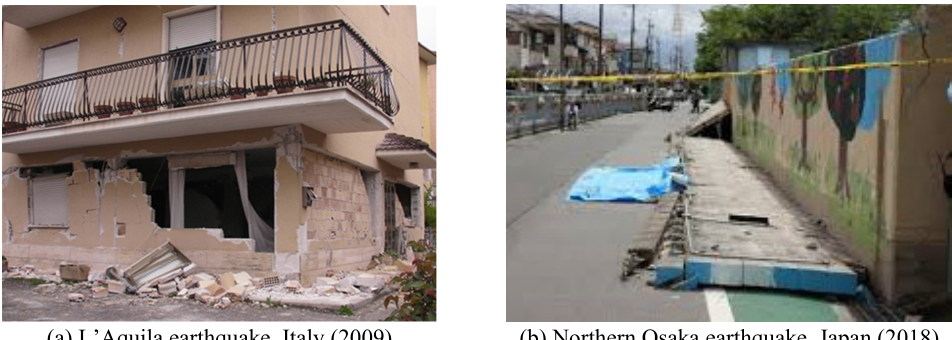
Figure 1. Masonry wall damage.